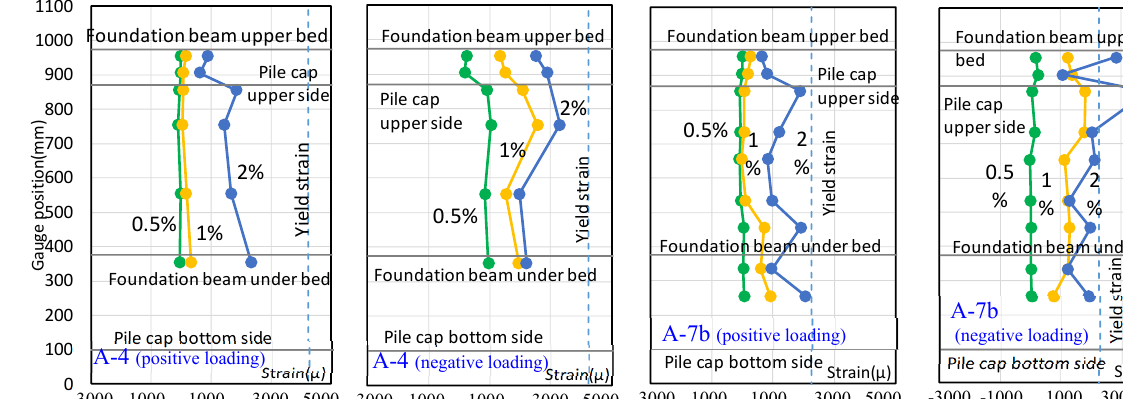
Figure 6. Strain distribution of column hoops in pile